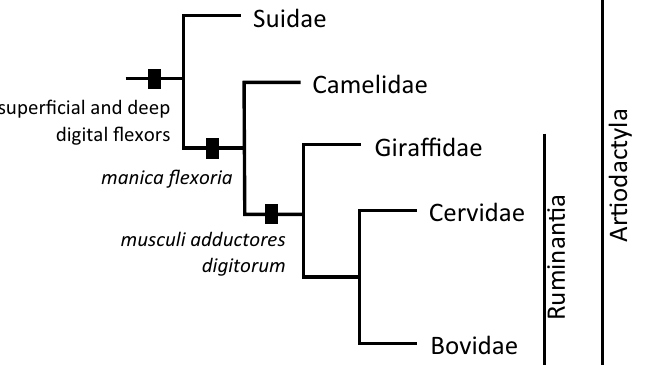
Figure 5. Simplified phylogenetic tree of even-toed ungulates (based on Hassanin et al. 44 ) with a specification of the distribution of several morphological traits of the autopod mentioned in the